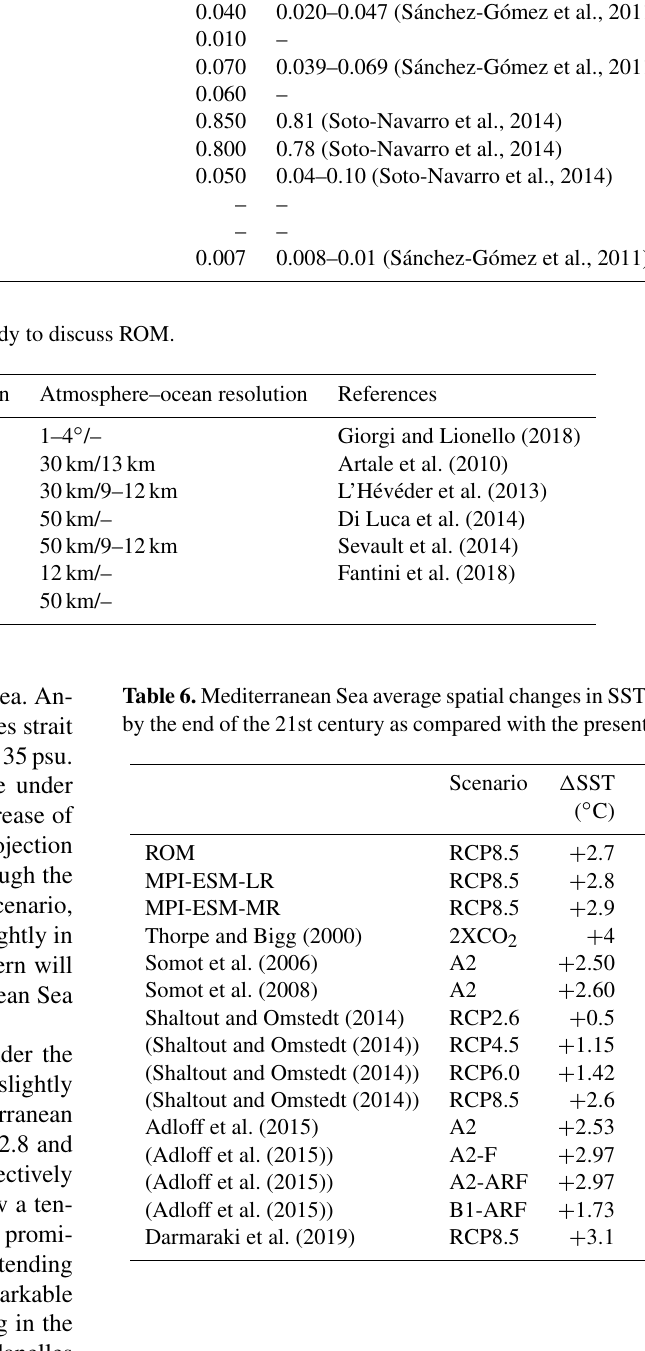
(Table 4), but the salinity change dipolar spatial pattern is roughly the same in all three projections (Figs. 13d and 14c and